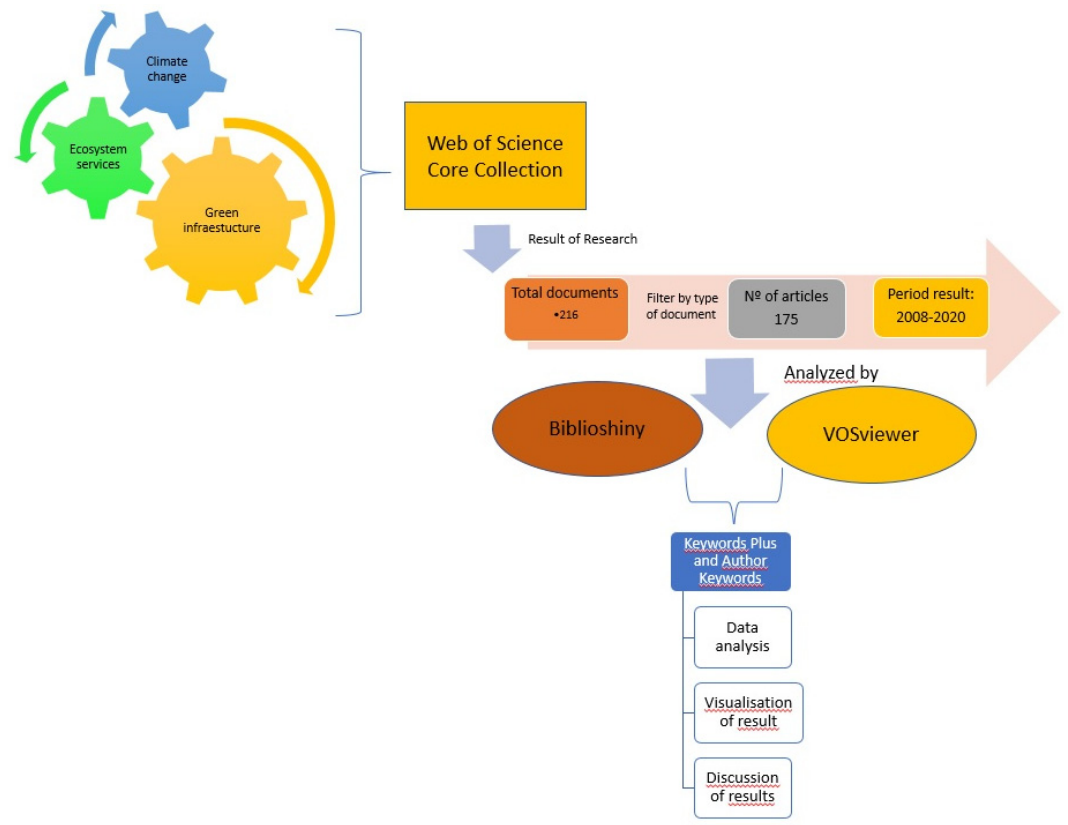
Figure 2. The Data Processing Procedure. Source: Own compilation.